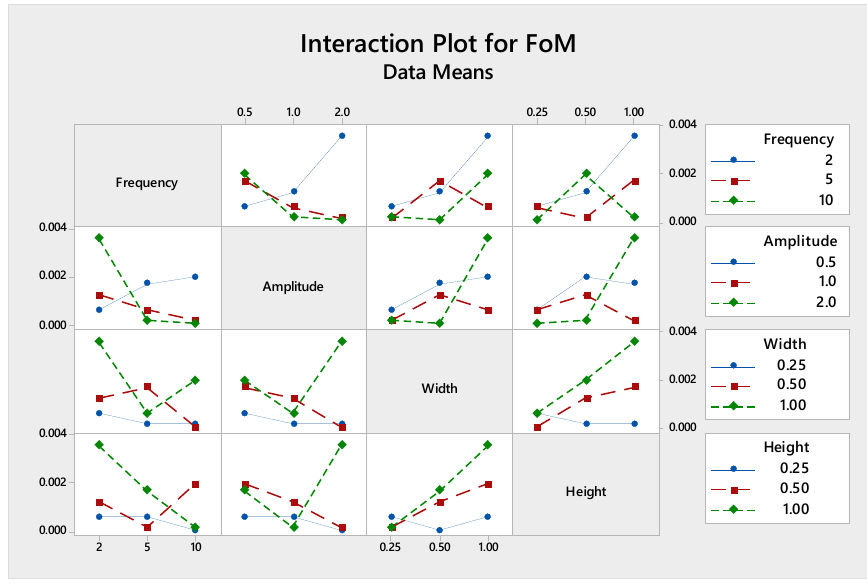
Figure 8. The interactions of various parameters with respect to figure of merit (FoM).